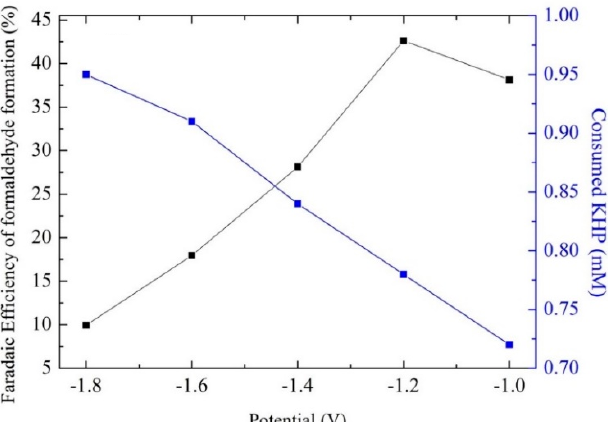
Figure 5. Faradaic efficiency to formaldehyde (black) and potassium hydrogen phthalate (KHP) consumption (blue) as a function of the potential in a BDD-BDD cell, reproduced from [105], Copyright (2020), with permission from Elsevier.